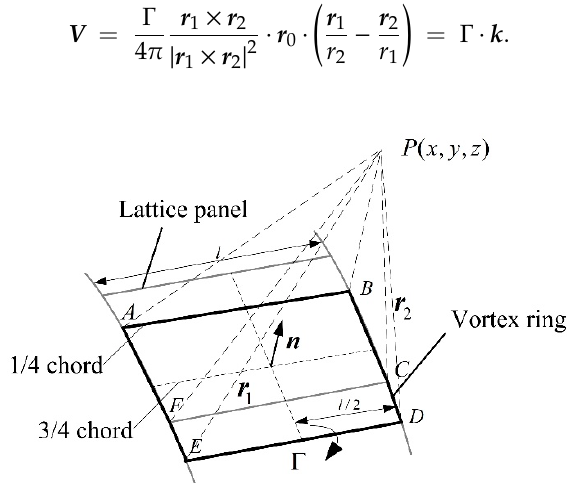
Figure 1. Vortex ring and induced velocity.